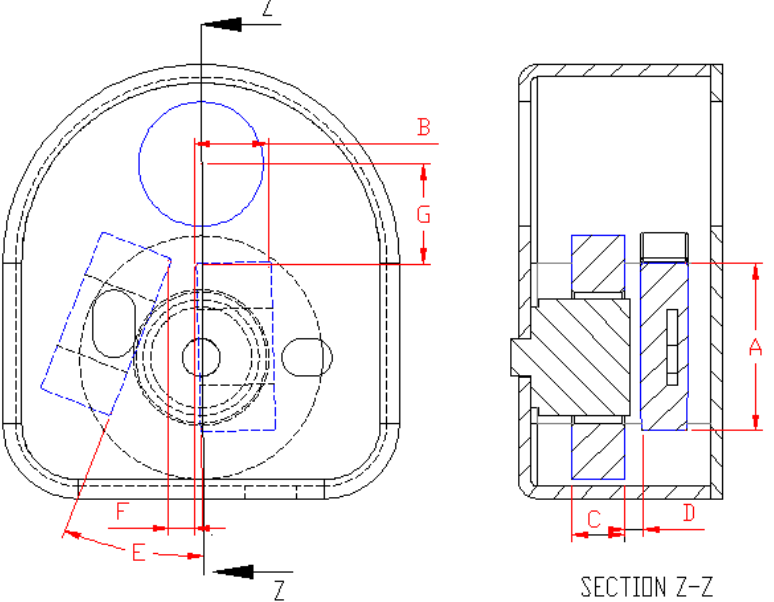
Figure 2. Assembly drawing of rotating electromagnet ( right ) and parts drawing ( left ). The current fault is that the movable iron core cannot reach the specified position or reach the specified position when it is energized in the forward direction, but returns to the original position when it is not energized in the forward direction (i.e., insufficient retention force). After analyzing the fault, the engineer believes that there may be two reasons: one is the problem in the design of the permanent magnet, and the other is the problem in the external coordination relationship of the permanent magnet. The specific size or fit relationship is shown in Figure 3.